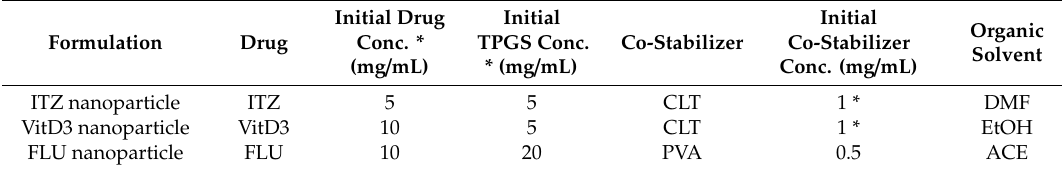
Figure 2. The ( A ) experimental set-up and ( B ) schematic of multi-inlet vortex mixer (MIVM). Table 2. The formulation parameters of nanoparticles.